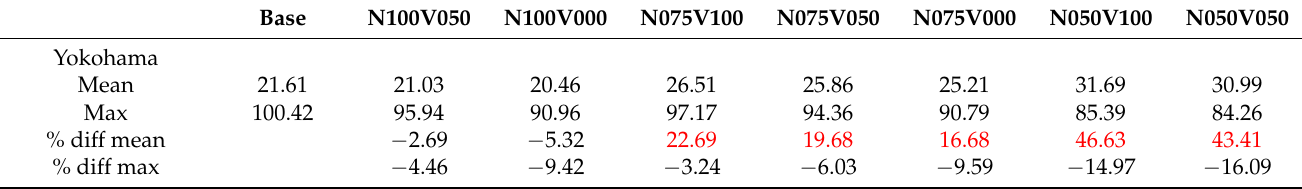
Table 2. Mean, maximum, and % difference in the ozone concentrations for the 21 simulated scenarios in seven points in Kanto (ppb). Values in red indicate increased ozone